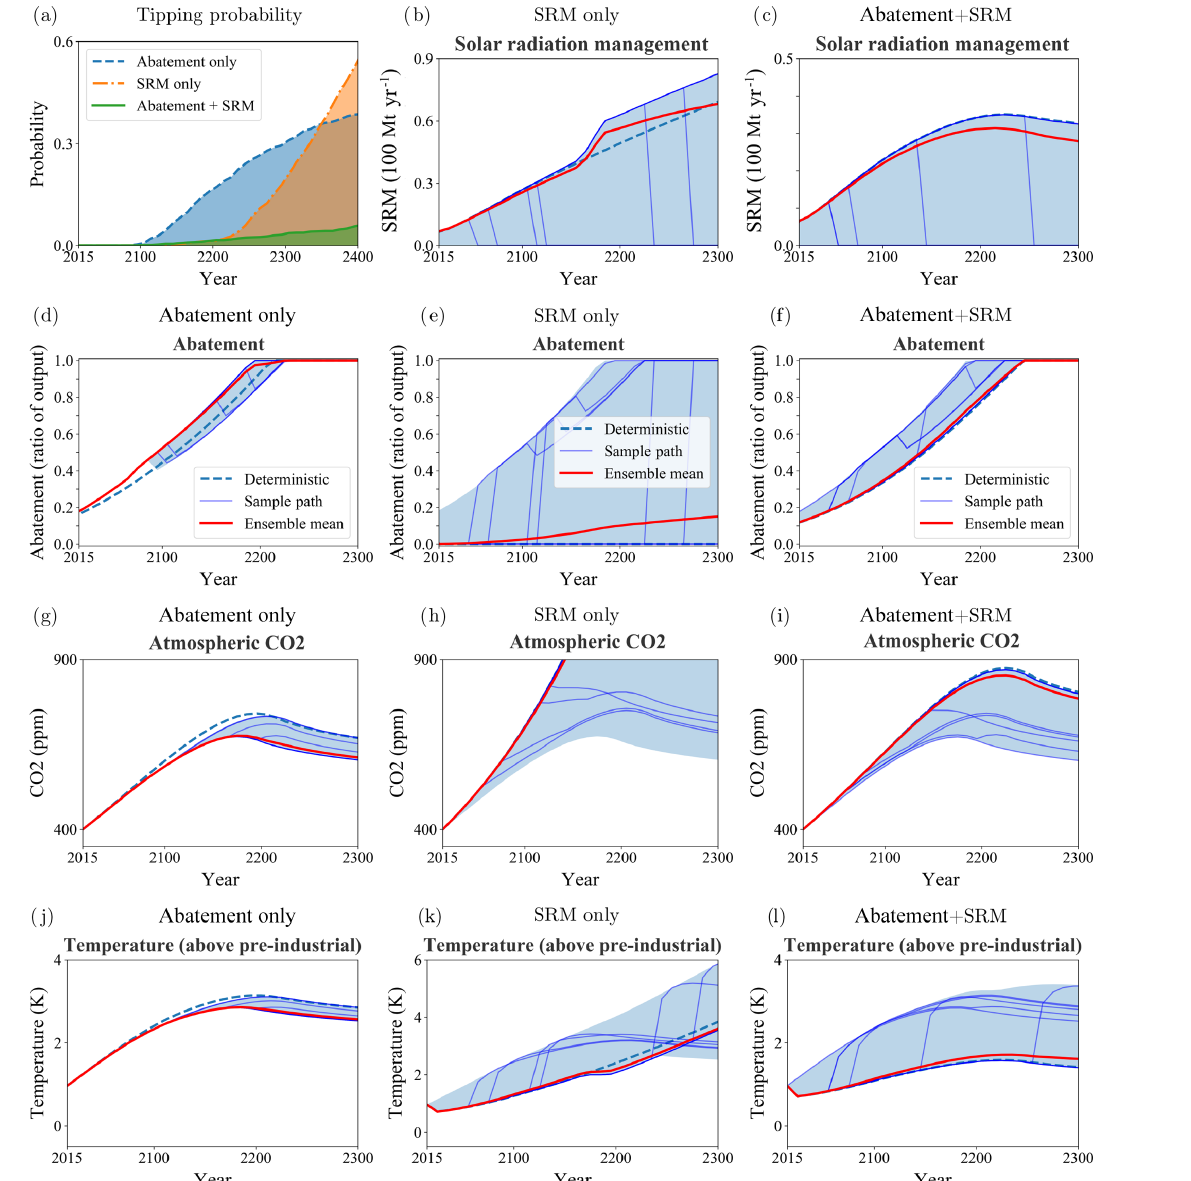
Figure 3. Tipping risk and policy in the stochastic setting (i.e. with tipping point and SRM failure). (a) cumulative probability of tipping for abatement-only scenario (blue dashed line), SRM-only scenario (yellow dash-dotted) and abatement+SRM scenario (green solid). (b– l) policy and climate response for the same scenarios (zoomed in on years 2015–2300 to enhance readability), namely abatement-only ( d , g , j ), SRM-only (b, e, h, k) , and abatement+SRM (c, f, i, l) scenarios. Variables shown are SRM deployed (b, c) ; note the different y -axis scale), abatement fraction (d, e, f) , atmospheric CO2 content in ppmv (g, h, i) , and global mean temperature change (j, k, l) ; note the different y -axis scale). The thin blue lines represent a sample of individual ensemble members, the thick red line the ensemble mean, and the blue shaded area indicates the range of possible values in the whole ensemble. The dashed blue line depicts the results from the deterministic case (Fig. 2) for